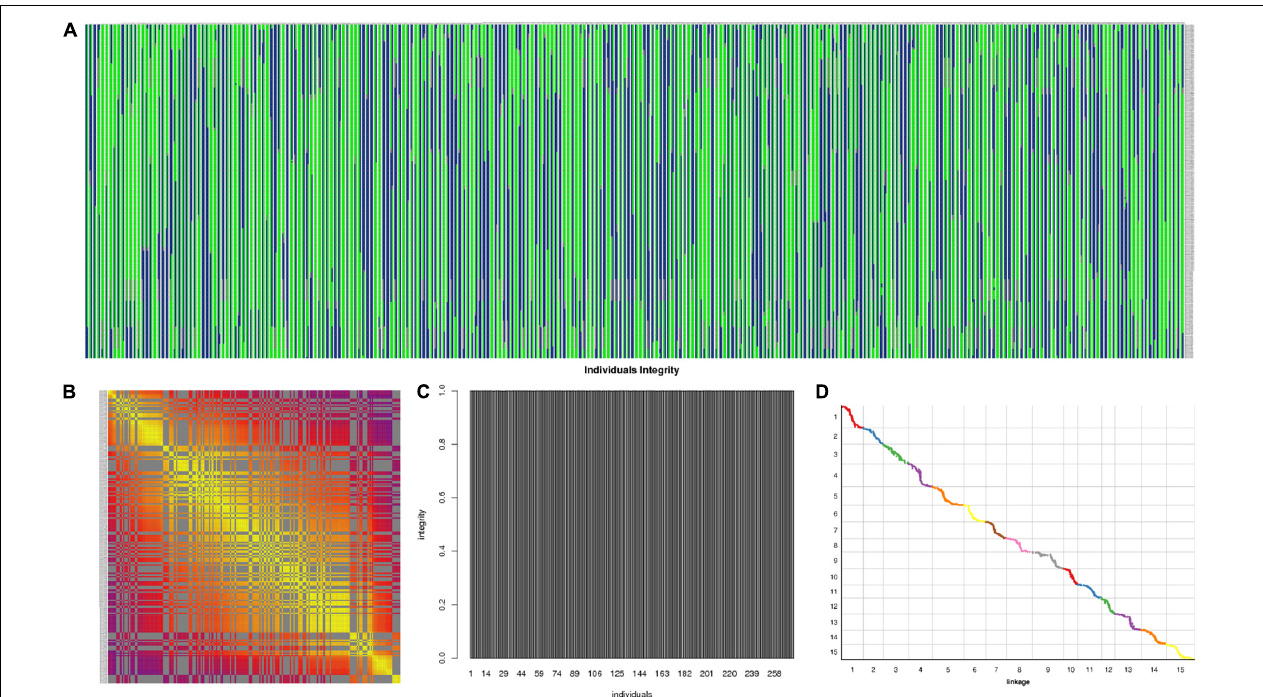
FIGURE 5 | Evaluation of the genetic map. (A) Haplotype maps for each individual; (B) heatmap of integrated group LG1; (C) average integrity of mapping markers; (D) collinearity analysis between the linkage map and the corresponding physical map.